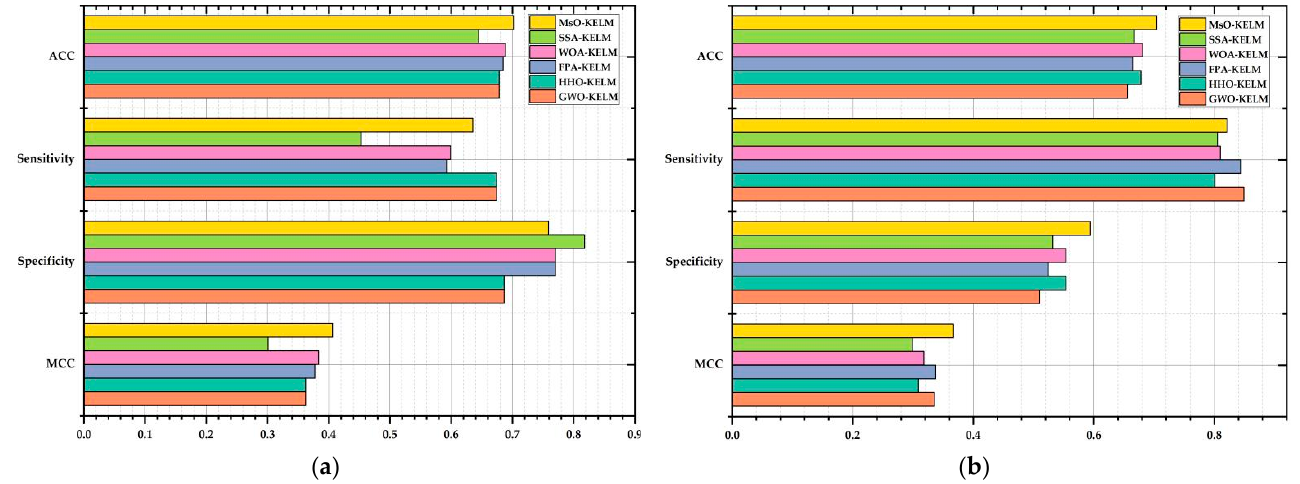
Figure 7. The figure of evaluation metric results on Cleveland and Bupa. ( a ) the evaluation criterion result on Cleveland; ( b ) the evaluation criterion result on Bupa. result on Cleveland; ( b ) the evaluation criterion result on